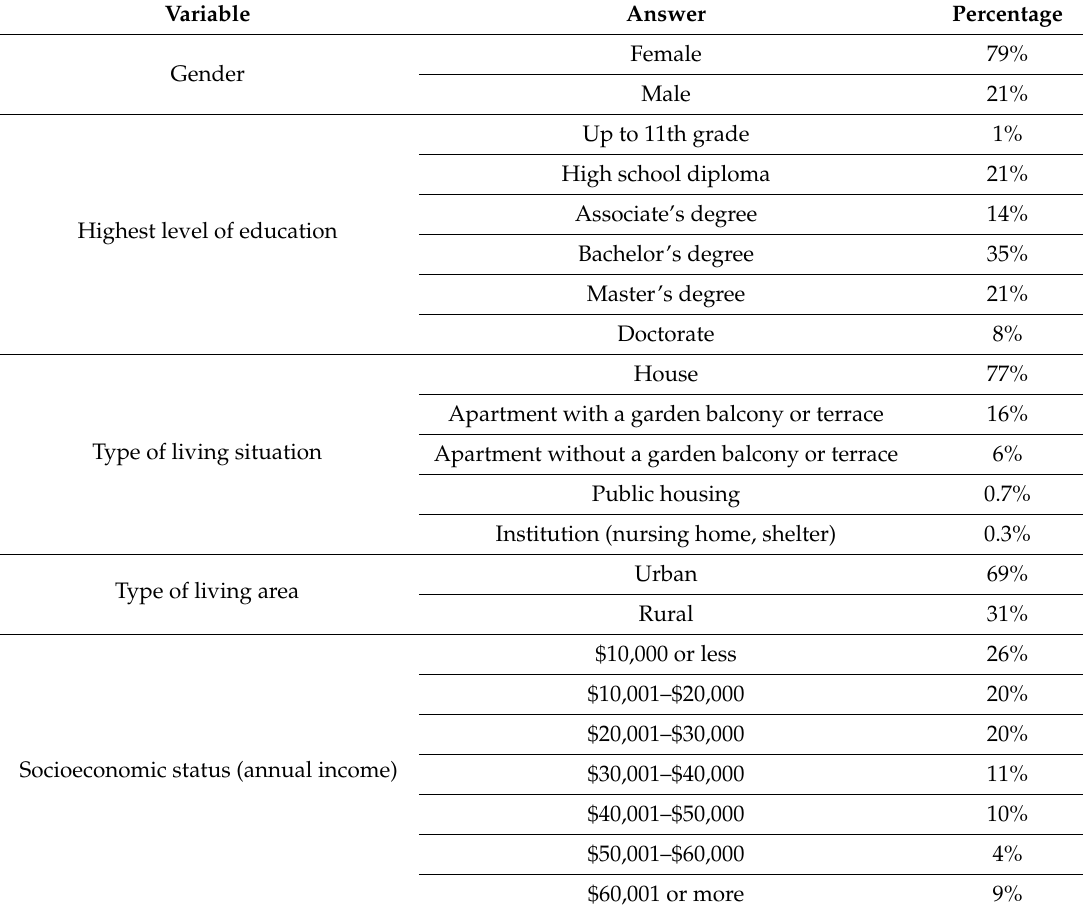
Table 1. Demographic details of the